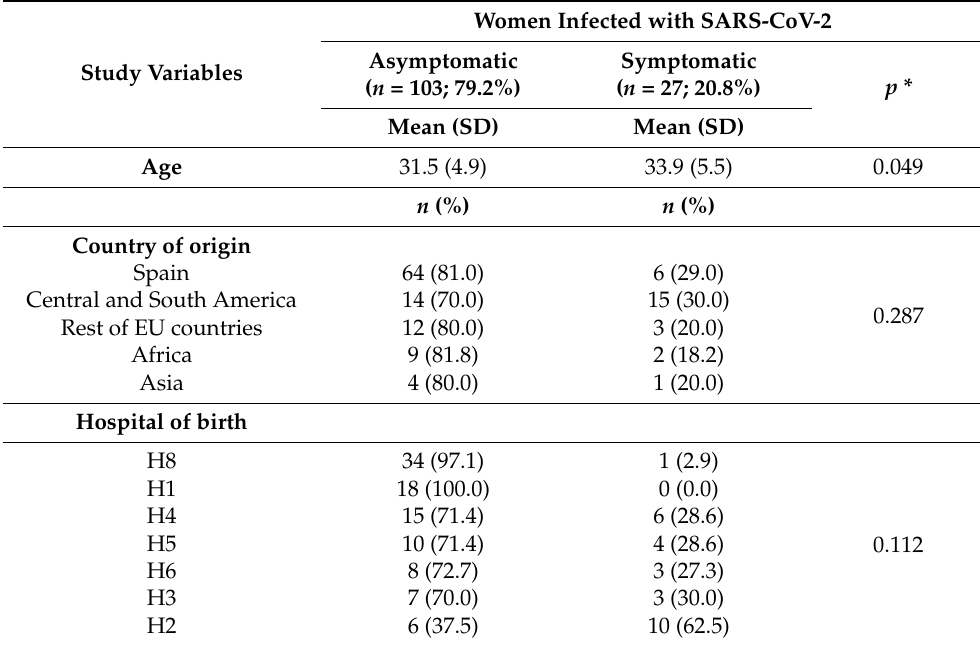
Women Infected with SARS-CoV-2 Asymptomatic Symptomatic ( n = 103; 79.2%) ( n = 27; 20.8%)